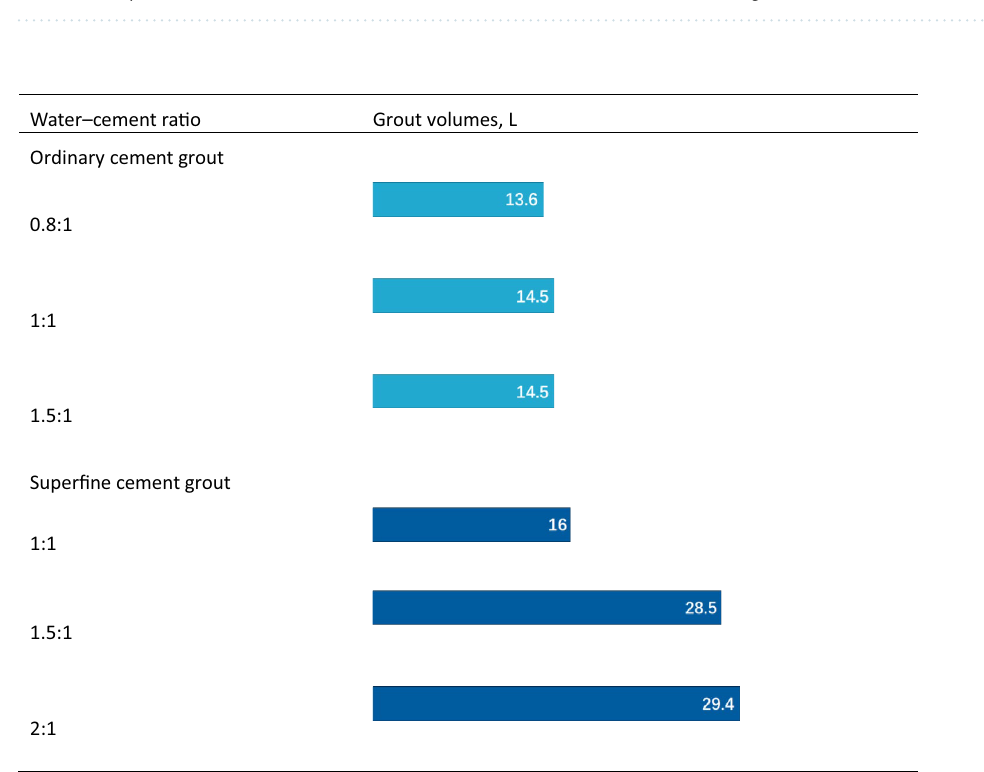
Table 3. Physical and mechanical indexes of reinforced modified sodium silicate grout.